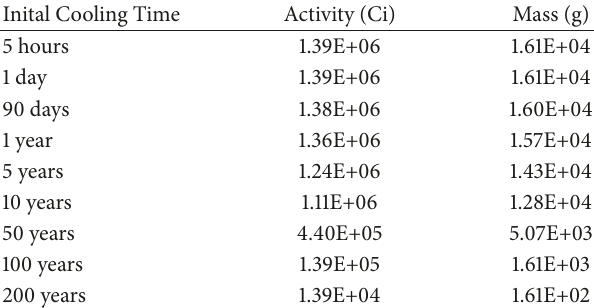
Table 2: Activity and mass of Cesium-137 in the spent fuel per cask.